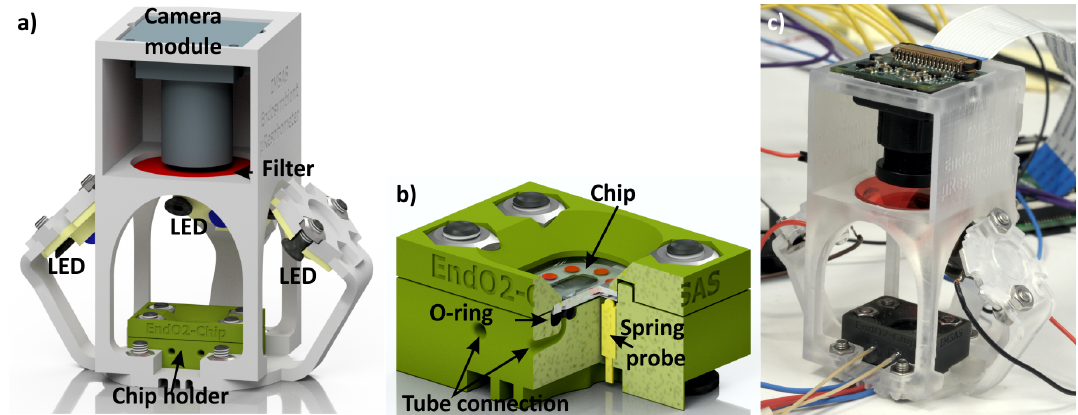
Figure 8. The measurement setup to investigate biological samples. The LEDs, optical filter and RaspberryPi camera are utilized to conduct fluorescence experiments of the samples, located in the chip. ( a ) A 3D rendered image of the measurement setup; ( b ) the microfluidic chip holder (17mm × 24mm × 11.5mm) containing fluidic and electric connections; ( c ) photo of the measurement setup (52mm × 68mm ×